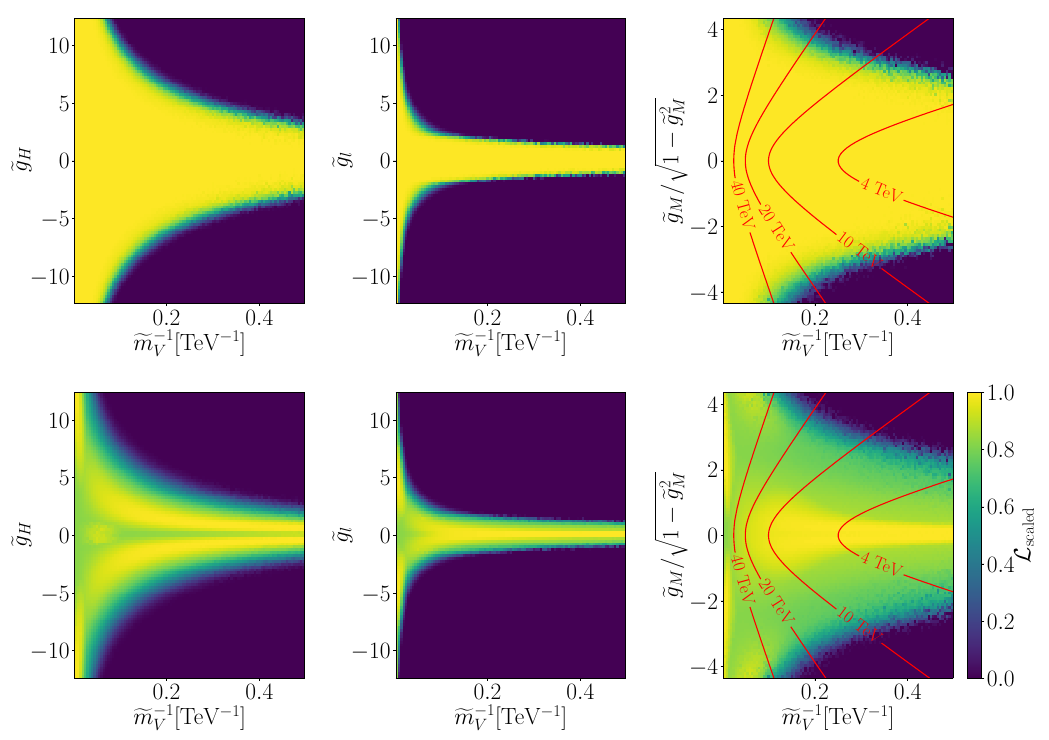
Figure 3: Results of the same global analyses as in Figs. 1 (upper) and 2 (lower), projected on ˜ m remain perturbative, the most stringent constraints on ˜ g